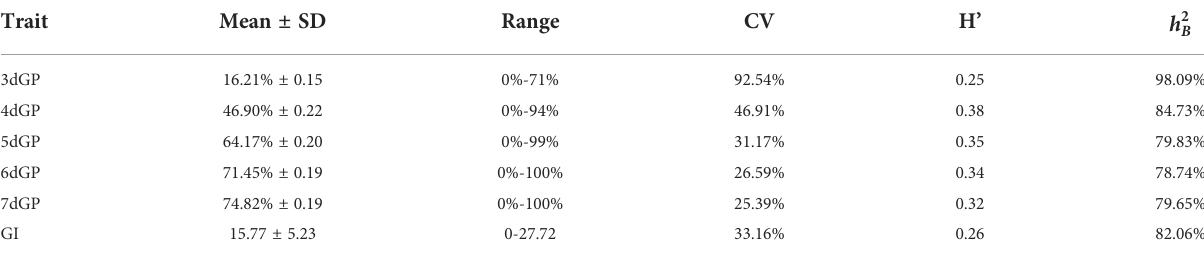
TABLE 1 Statistical analysis of germination potential (GP) on different days and germination index (GI) under salt stress.